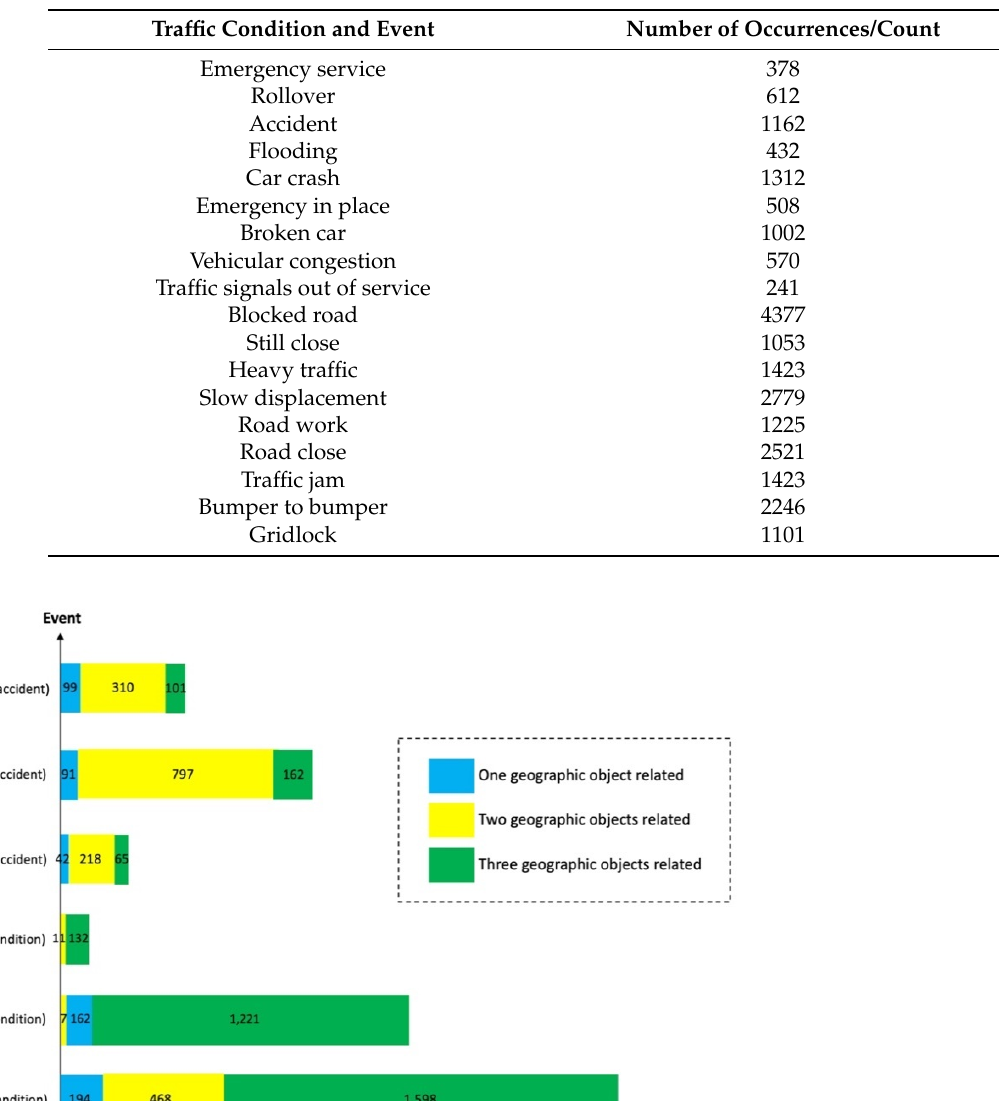
Table 1. Common traffic conditions and events mentioned in the tweet dataset.